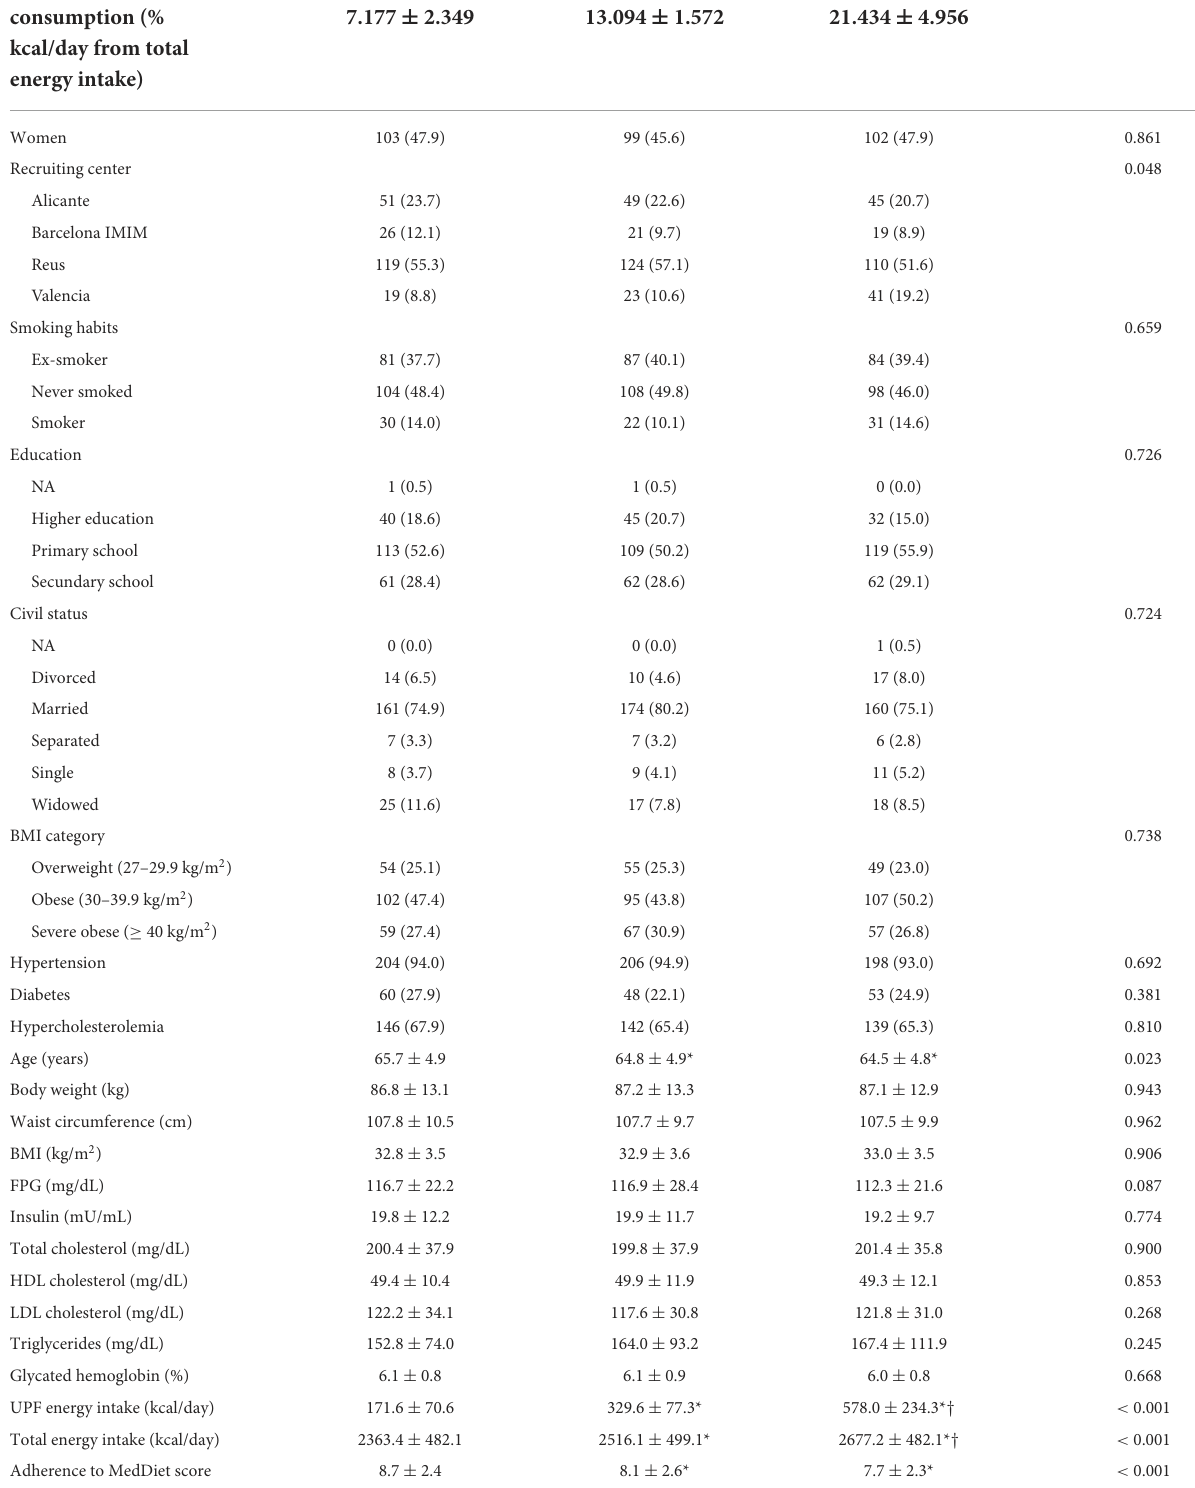
TABLE 2 Characteristics of the study population according to tertiles of UPF consumption. Tertiles of